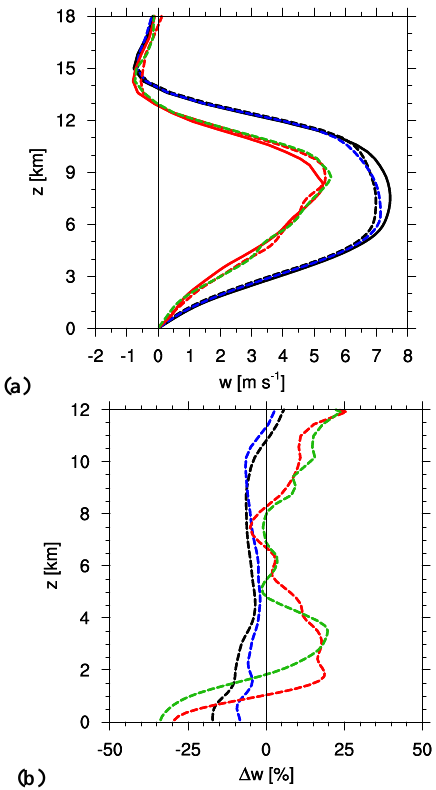
Fig. 18. The change in mean cloud top height is depicted for the “Semi-Polluted” (dashed) and “Polluted” (dotted) scenarios relative to the “Clean” case using both the bulk (black) and bin (red) micro- physics schemes for the (a) highRH and (b) lowRH scenarios.